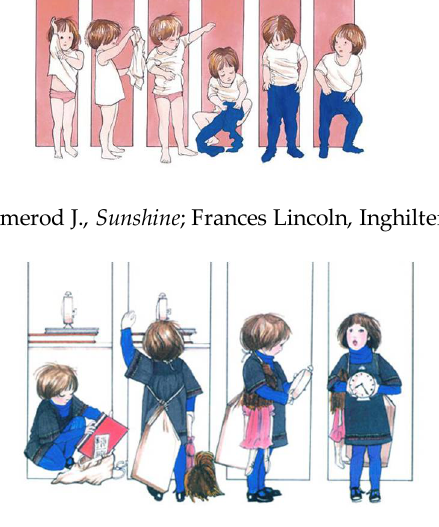
Figure 6. Ormerod J., Sunshine ; Frances Lincoln, Inghilterra 2005,